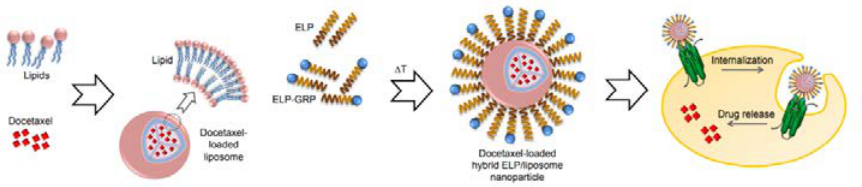
Figure 12. Scheme of the process of specific targeting of prostate cancer cells with hybrid elastin-like polypeptide (ELP)/liposome nanoparticles. Adapted from [79].